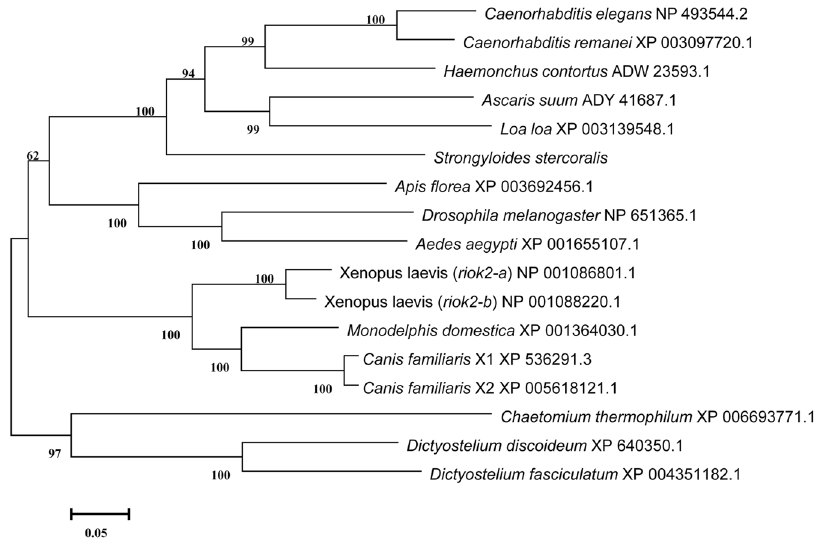
Figure 2. The neighbour-joining tree of RIOK-2 amino acid sequences from a range of organisms. These species are Ascaris suum (ADY41687.1), Caenorhabditis elegans (NP_493544.2), Caenorhabditis remanei (XP_003097720.1), Haemonchus contortus (ADW23593.1), Loa loa (XP_003139548.1), Aedes aegypti (XP_001655107.1), Apis florea (XP_003692456.1), Canis familiaris (XP_536291.3, XP_005618121.1), Drosophila melanogaster (NP 651365.1), Dictyostelium discoideum (XP_640350.1), Dictyostelium fasciculatum (XP_004351182.1), Chaetomium thermophilum (XP_006693771.1), Monodelphis domestica (XP_001364030.1), Xenopus laevis (NP 001086801.1, NP 001088220.1). Accession numbers for the various sequences in the NCBI Protein Database are given next to each species name. Numbers represent bootstrap values (after 1000 iterations) and the scale bar represents branch length as a fraction of the total tree length. The bootstrap values of > 95% were displayed in the